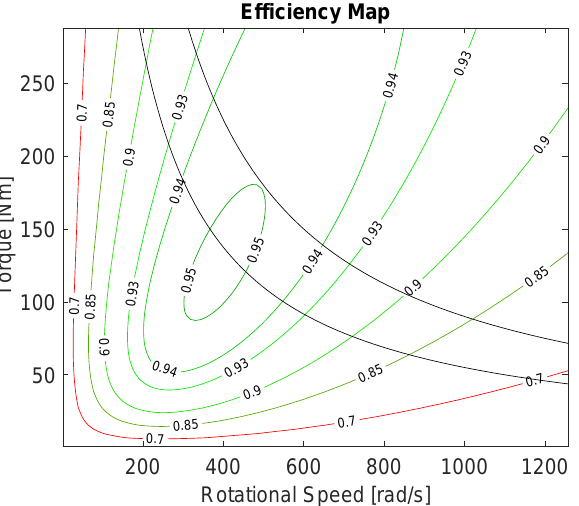
Figure 7. Example of an approximate efficiency map. Isolines indicate regions of equal efficiency. The two dark lines indicate the maximum and nominal power